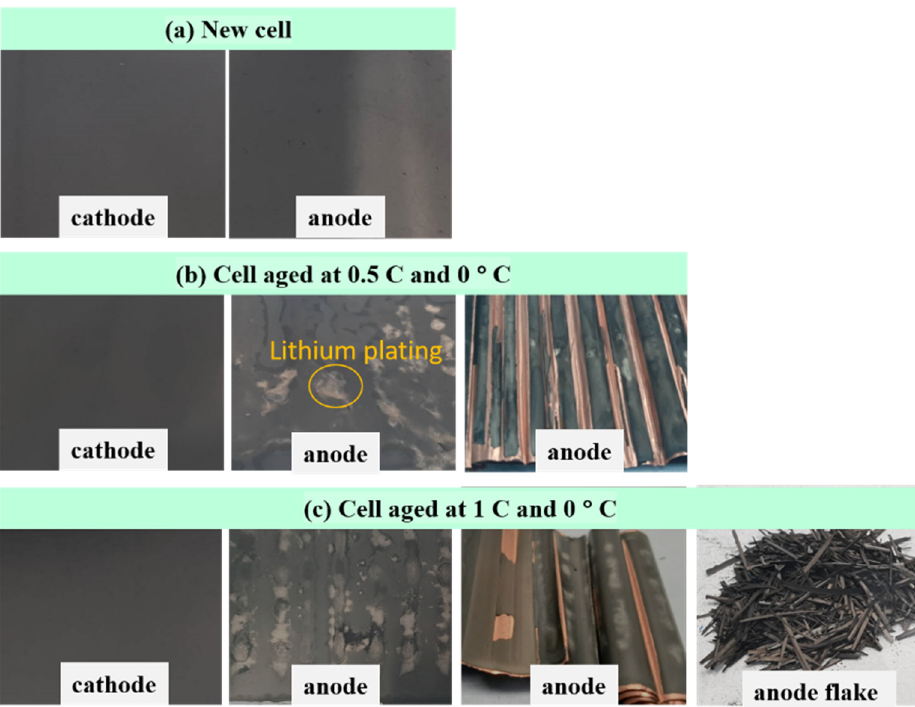
Figure 7. Electrodes harvested from new and cold aged cells.